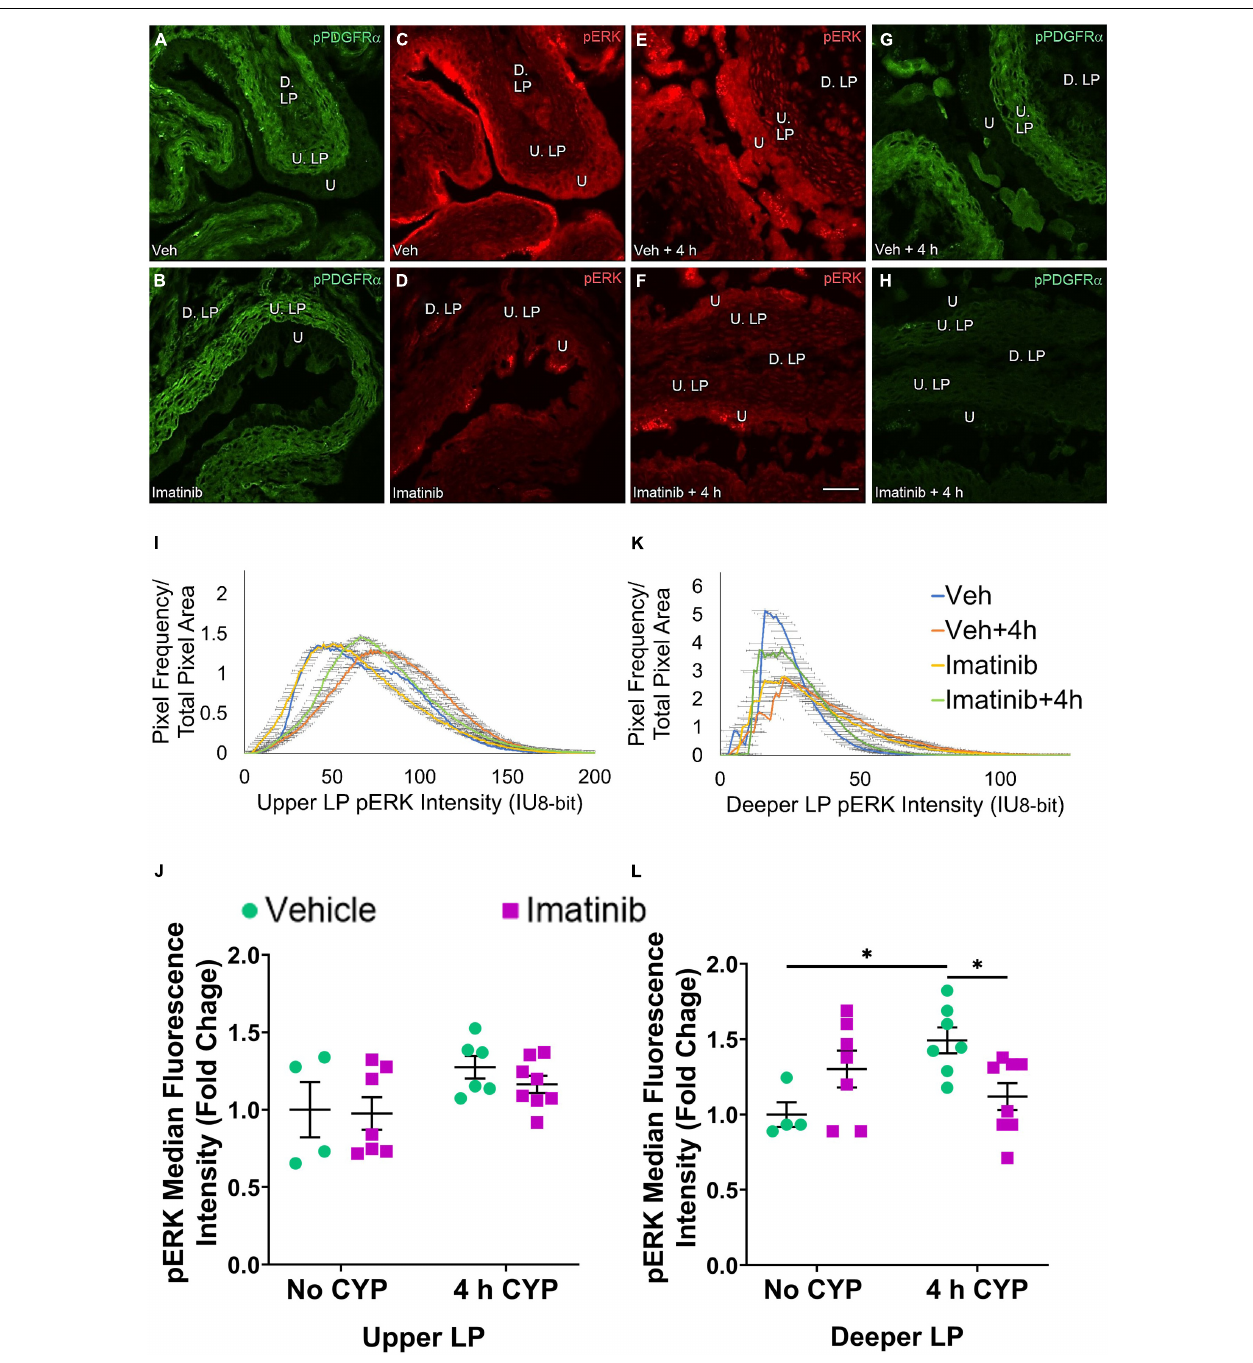
FIGURE 9 | Transurethral bladder infusion of imatinib mesylate reduces pERK expression in the deeper lamina propria (D. LP), but not upper lamina propria (U. LP), in an acute (4 h) cyclophosphamide (CYP)-induced cystitis female mouse model. Representative (A–H) images, (I) upper LP and (K) deeper LP fluorescence intensity curves of pERK immunoreactivity (CY3, red) in the urinary bladder (10 µ m sections) in female mice with (E) acute (4 h) cyclophosphamide (CYP)-induced cystitis (200 mg/kg, i.p.) and (C,D) controls (no CYP), (F) treated with imatinib mesylate via transurethral intravesical infusion (50 µ M, 30 min). (A,B,G,H) Bladder tissue was co-stained for pPDGFR α (FITC, green), and the corresponding images are displayed to provide orientation. 4 h CYP treatment significantly ( p ≤ 0.05) increased pERK expression in the (L) D. LP (1.5-fold) but not the (J) U. LP, compared to vehicle controls. Imatinib treatment significantly ( p ≤ 0.05) reduced pERK expression in the (L) D. LP (1.3-fold), but not the (J) U. LP in female mice with 4 h CYP-induced cystitis. Raw IHC values (intensity units, 8-bit) are presented as fold change values ± SEM with respect to the control group (vehicle, no CYP). n = 4–8. * p ≤ 0.05; ** p ≤ 0.01; *** p ≤ 0.001; **** p ≤ 0.0001 by two-way ANOVA with Tukey’s multiple comparisons test. Tissues were processed simultaneously. Microscope and camera settings were kept constant across all groups. Fluorescence intensity was measured using Volumetry image analysis software (VolumetryG9a, Grant Hennig). Scale bar = 50 µ m. U, urothelium; U. LP, upper lamina propria; D. LP, deeper lamina propria; IU, intensity